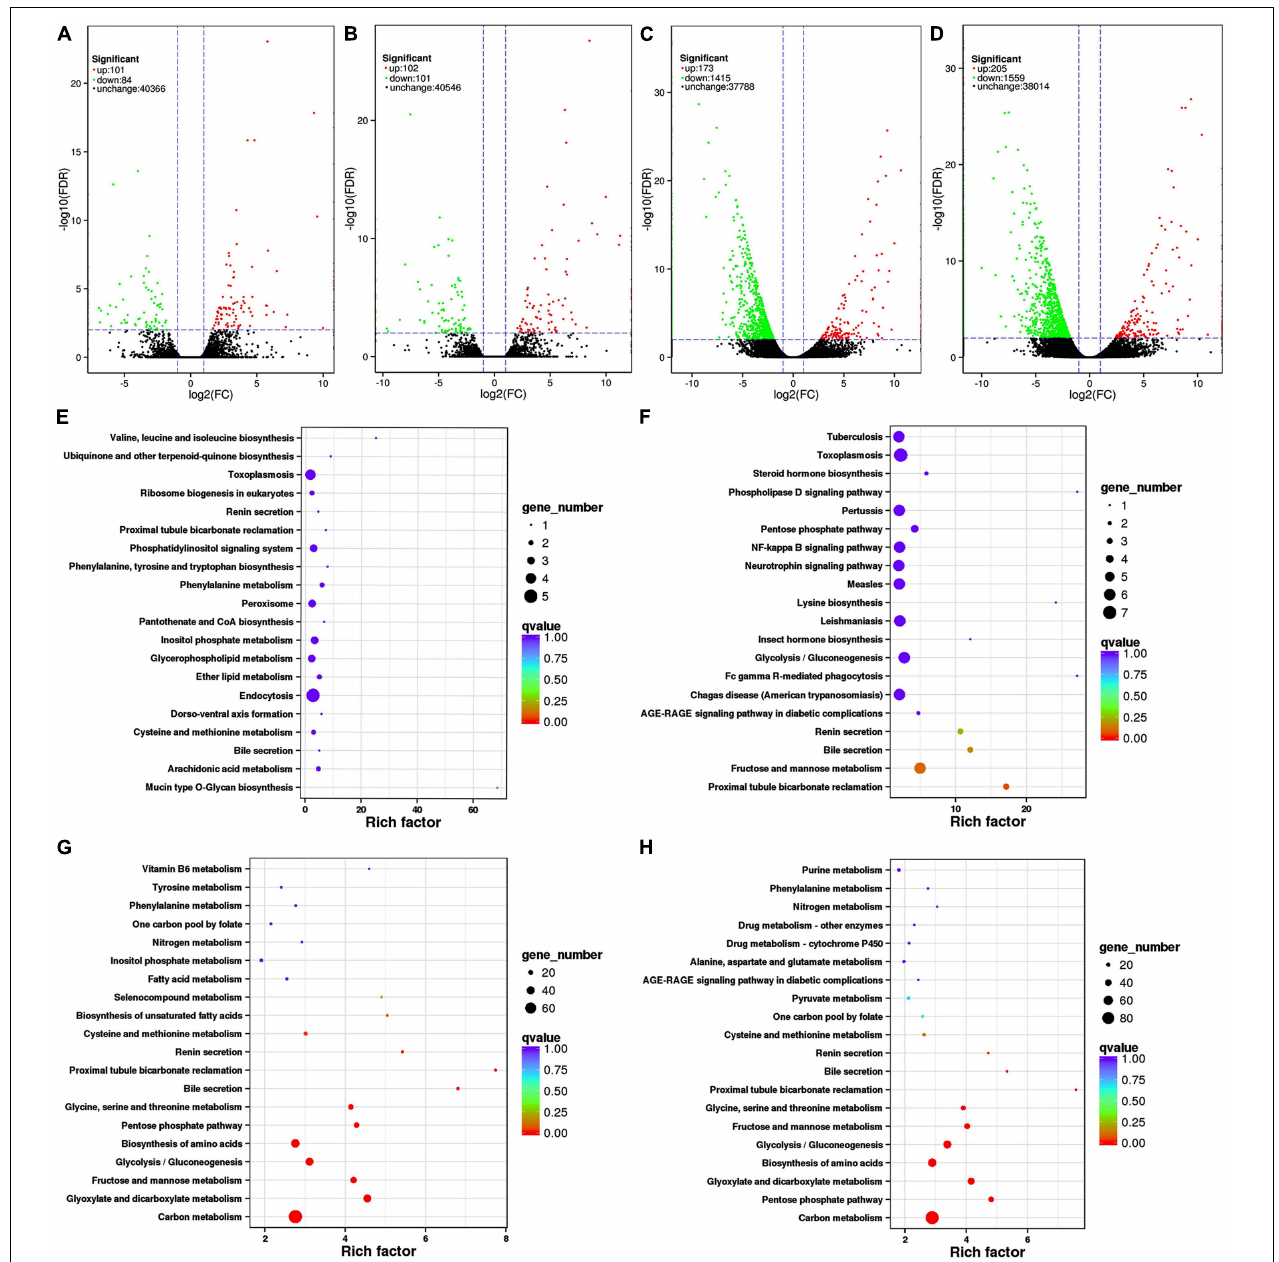
FIGURE 2 | Volcano plots and pathway enrichment of differently expressed transcripts in K. pentacarpos seedlings under saline–alkali stress. (A–D) Volcano plots of CK-Tr1, CK-Tr2, CK-Tr3, and CK-Tr4. Green, red, and black dots represent down- and upregulated differential and non-differential expression, respectively. (E–H) Pathway enrichment of CK-Tr1, CK-Tr2, CK-Tr3, and CK-Tr4. The larger the enrichment factor, the more significant the enrichment level; the smaller the q -value, the more reliable the enrichment significance; and the larger the dot, the greater the number of